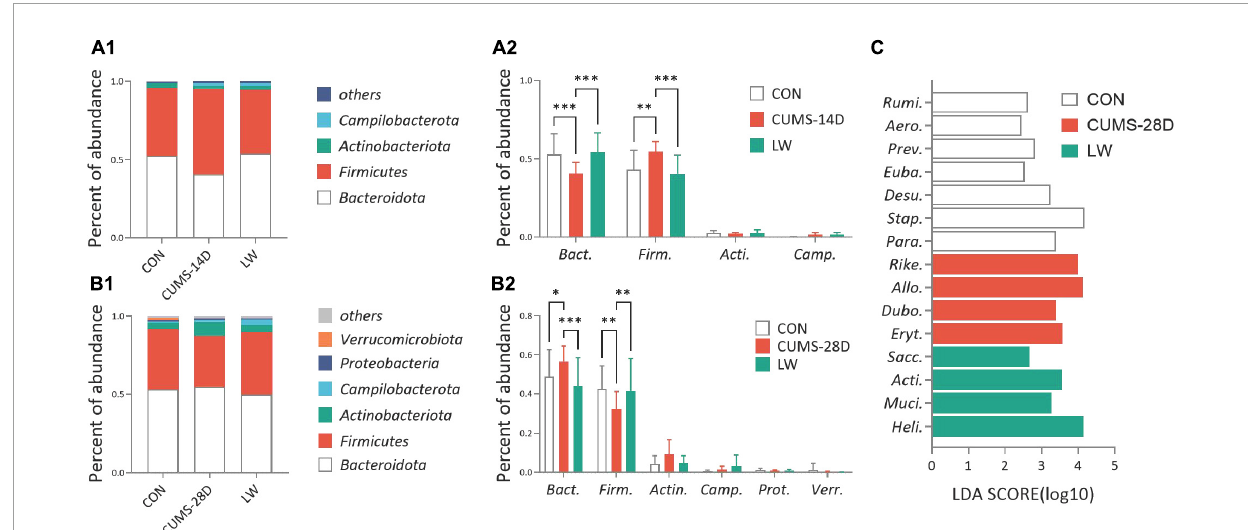
FIGURE5 Liuwei Dihuang formula reversed the relative abundances of the predominant bacterial taxon of gut microbiota in CUMS mice. The average abundance of the predominant bacterial phylum (with relative abundance > 1% in at least one sample) in CUMS-14D (A1) and -28D (B1) mice. Gut microbiota variations at the phylum level in CUMS-14D (A2) and -28D (B2) mice. (C) The linear discriminant analysis (LDA) effect size (LEfSe) classifying the most differentially abundant taxa at the genus level in CUMS-28D mice (| LDA| > 2 and P -value < 0.05 were shown). ∗ P < 0.05,